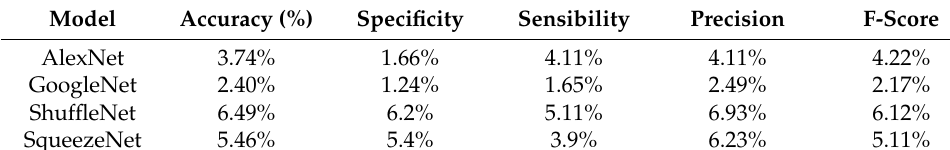
Table 7. Improvement percentages of performance criteria metrics of the proposed model.